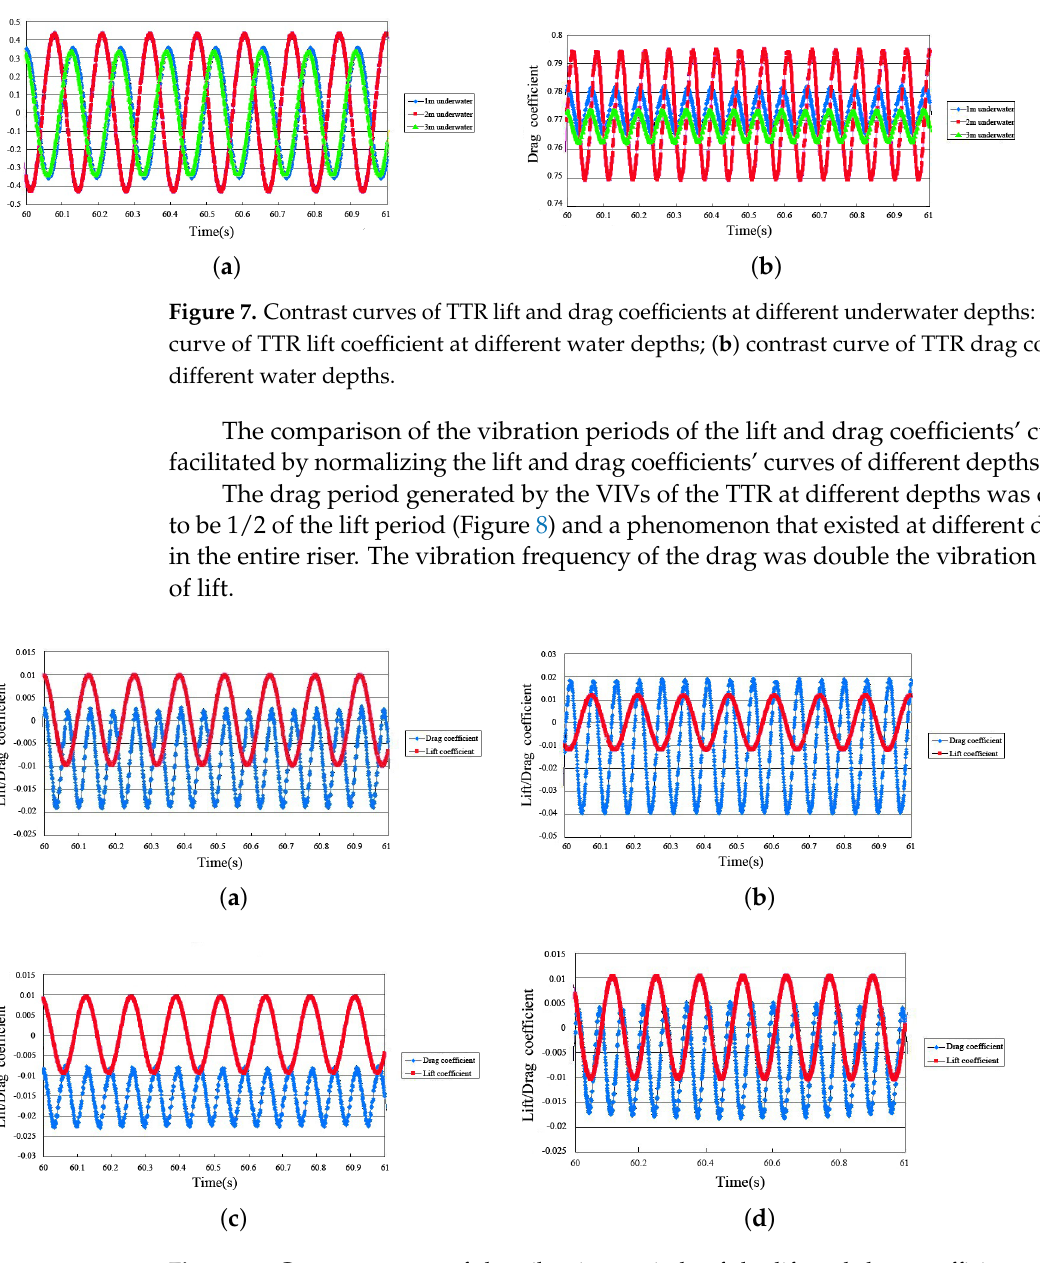
Figure 8. Contrast curves of the vibration periods of the lift and drag coefficients at different underwater depths in TTR: ( a ) contrast curve of lift and drag coefficients at 1 m underwater; ( b ) contrast curve of lift and drag coefficients at 2 m underwater; ( c ) contrast curve of lift and drag coefficients at 3 m underwater; ( d ) contrast curve of lift and drag coefficients of the entire